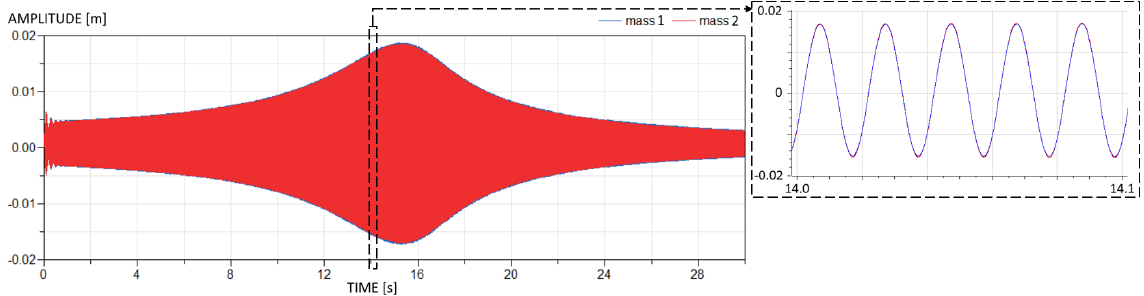
Figure 15. Mass amplitudes of the double mass–spring coupled with play ( f r = 50 hz).